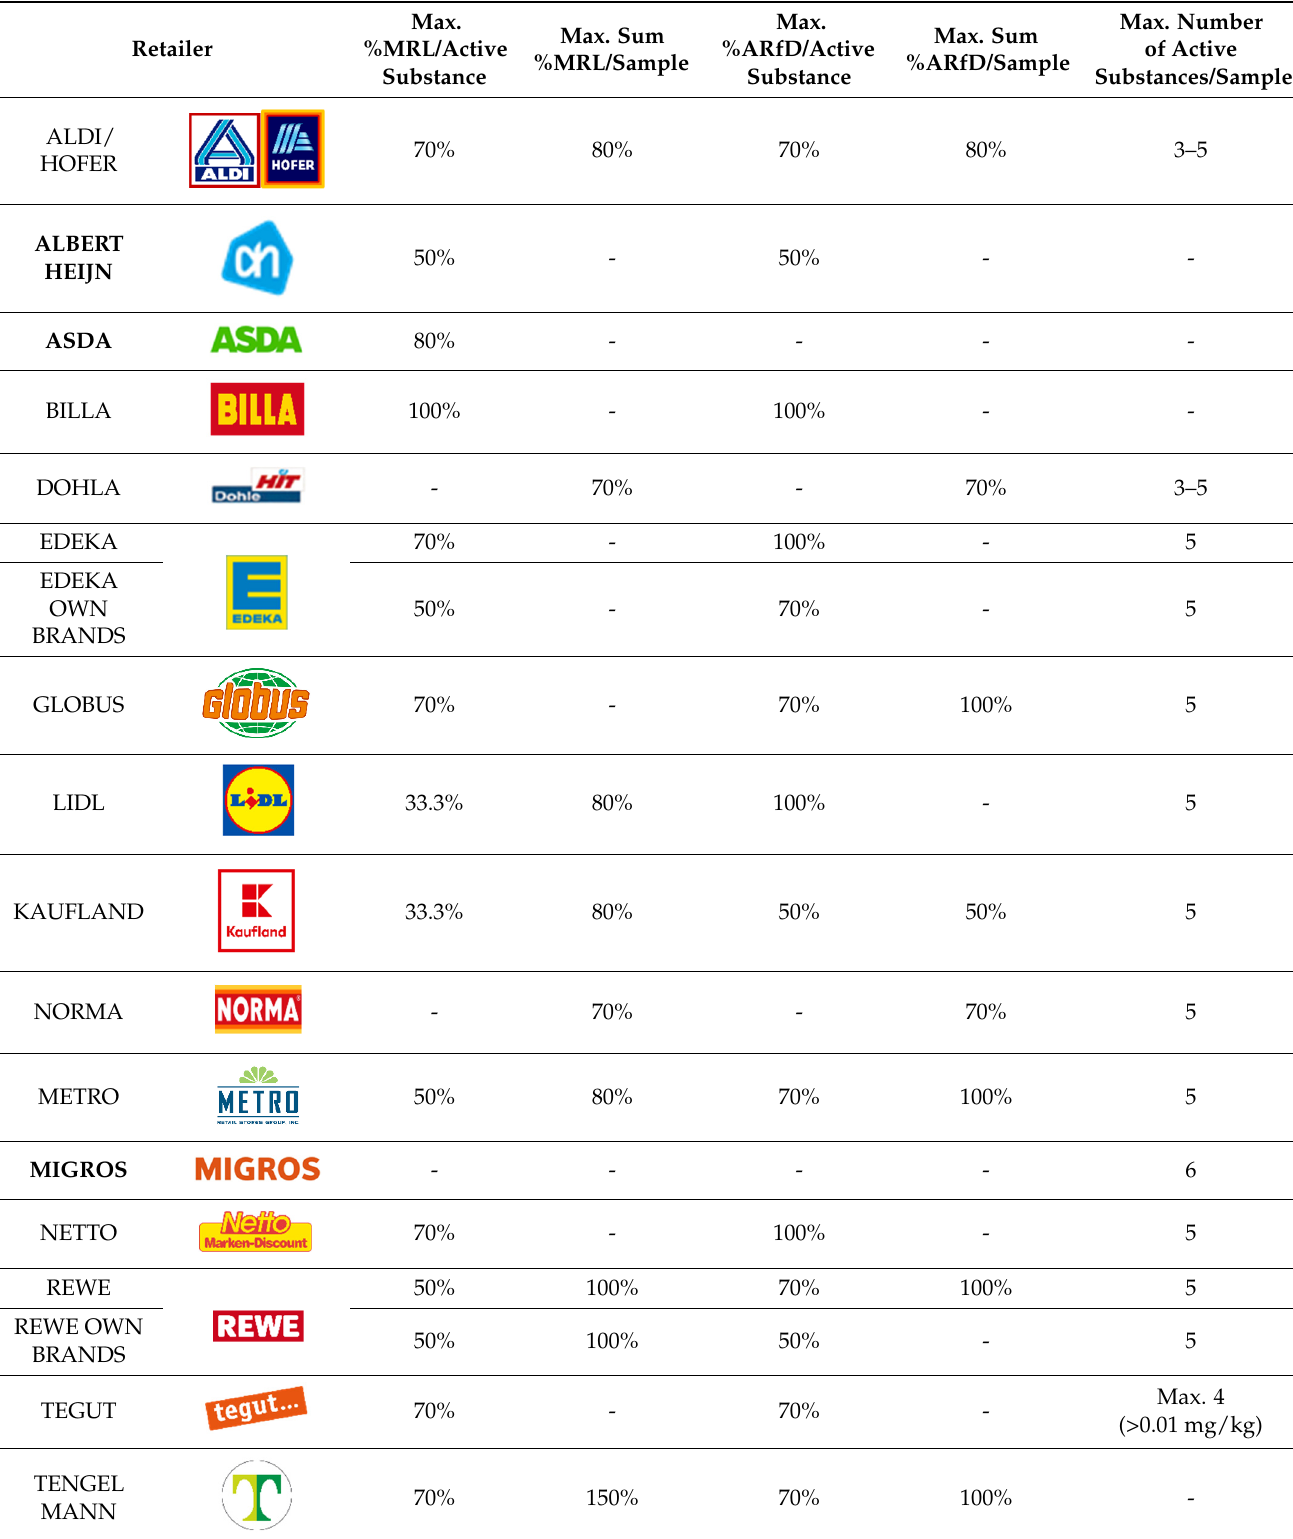
Table 5. Examples of requests from the retailer of the amount of the Maximum Residue Level (MRL) and Acute reference doses (ARfD).